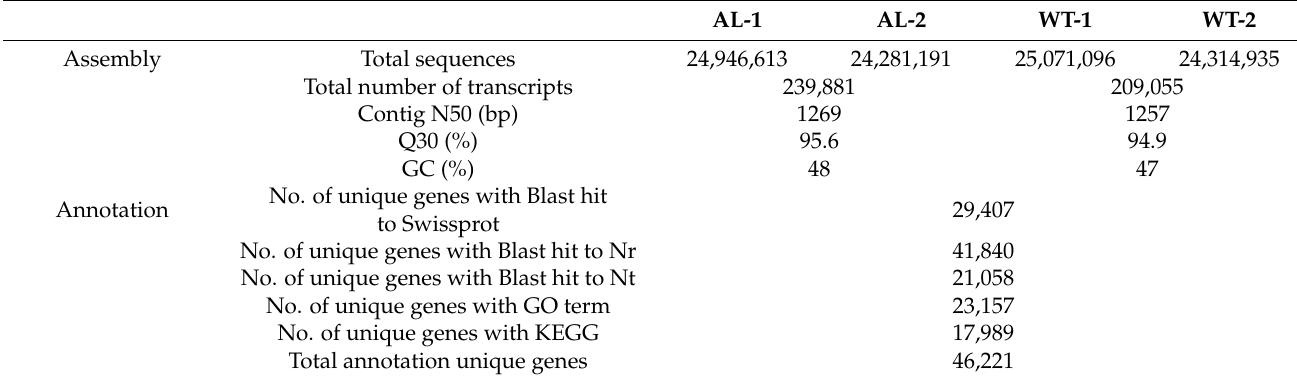
Table 1. Overall statistics based on the reads of the mRNA sequencing data.